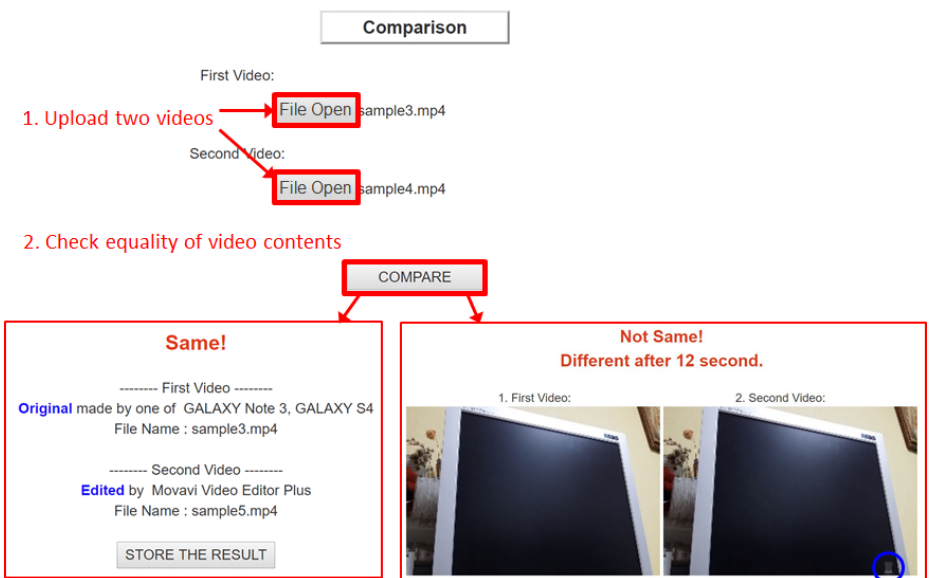
Figure 9. Graphic User Interface for the integrity preservation trace.